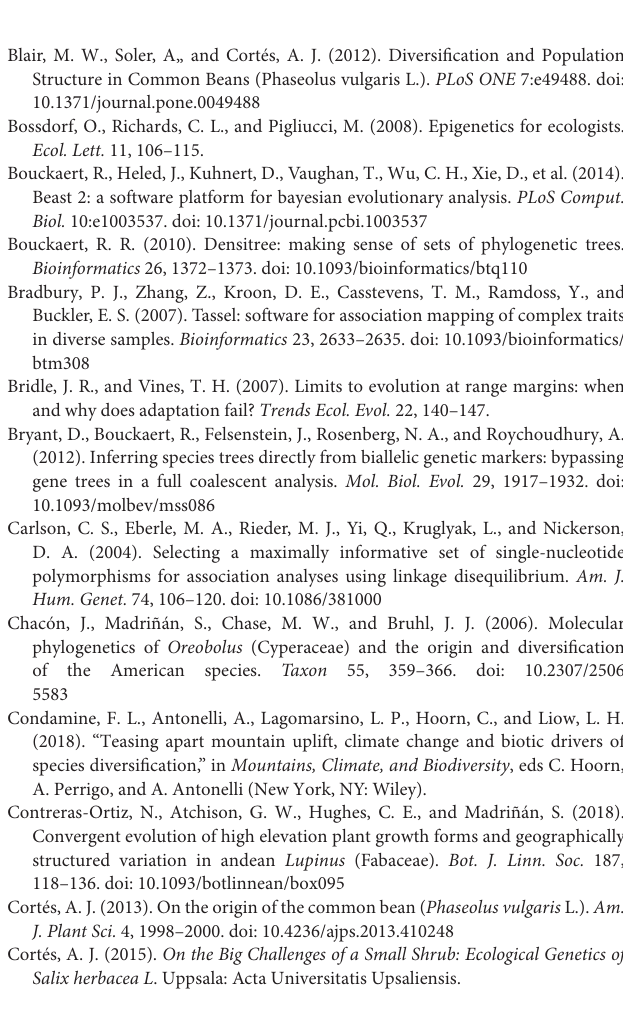
are based on the entire set of populations (A–D) , whereas the following three and four rows only include contrasting populations for localities (E–G) and for habitats (H–K) , respectively. First row of diagrams within these previous sets are based on the entire SNP dataset (A,E,H) , whereas second, third and fourth rows only include markers significantly associated (based on the optimum model among 18 different statistical models that accounted for phylogenetic distance) with the localities (B,F,I) , the theoretical exposure to frost (C,G,J) and the theoretical soil moisture content (D,K) , respectively. Lines are displayed where Mantel tests were significant according to Table 1 . TABLE S1 | Identity of the 19 Espeletia populations used in this study and spanning 162 samples growing in 3 different habitats and 6 localities. Taxa names follow Cuatrecasas (2013). Populations’ abbreviations are given by the combination of codes for localities and ecotypes. Localities are coded as follows: Under “Ecology” habitats are coded using an ordinal scale based on the theoretical exposure to frost and the theoretical soil moisture content. TABLE S2 | Population structure from assignment tests in STRUCTURE based on 1,273 variable SNP markers. Probabilities are shown for the optimum K -value ( K = 9, Supplementary Figure S2 ) according to Evanno et al. (2005), the PCoA ( Figure 2 ) and visual inspection. Populations are abbreviated as in Supplementary Table S1